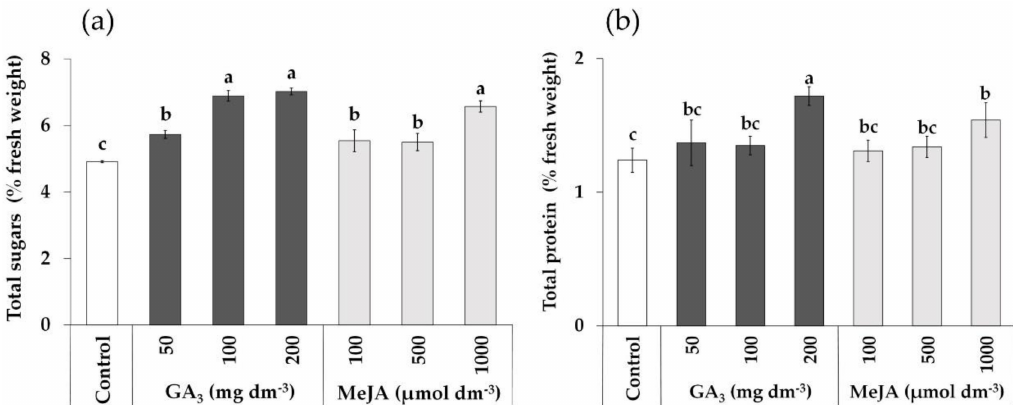
Figure 3. E ff ects of foliar application of GA 3 and MeJA solutions on total sugar ( a ) and total protein ( b ) content in the bulbs of × A. tubergenii “Zwanenburg”. Data are mean ± SD (n = 3). Di ff erent letters above the error bars indicate significant di ff erences for p <